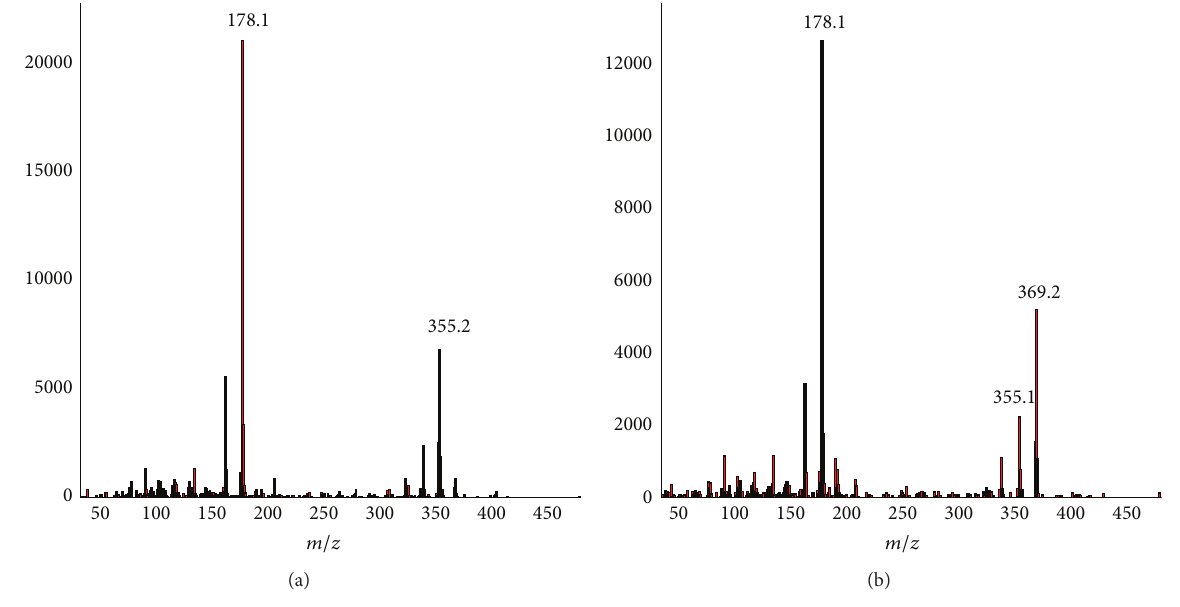
Figure 4: Mass spectrum (EI) of peak of P 4 (a) and P 5